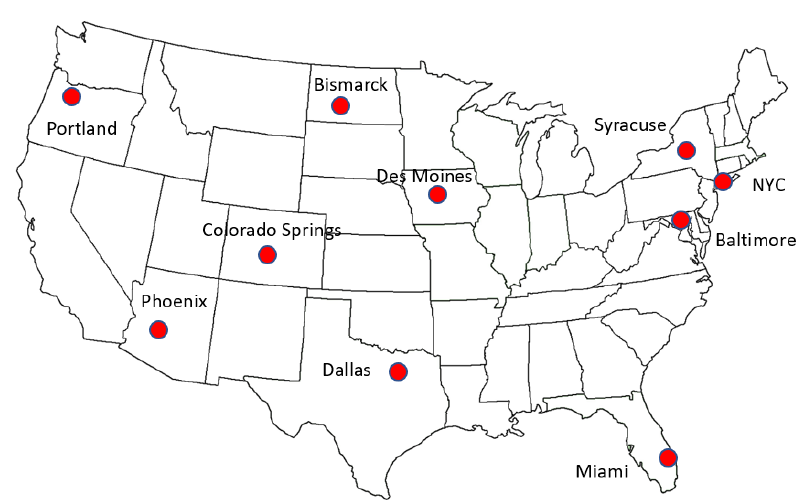
Figure 1. Location of the selected cities for this study across the contiguous United States (CONUS). Table 1. Examined GCMs general information and atmospheric model grid resolution (number of longitudinal grids × number of latitudinal grids)